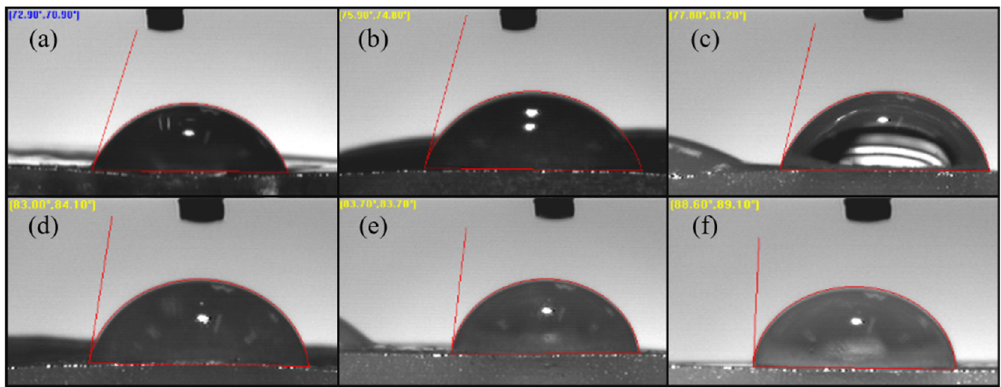
Figure 9. The contact angles of different concentrations of ( a ) AG10:50, ( b ) AGLC01, ( c ) AGLC05, ( d ) AGLC10, ( e ) AGLC20, and ( f ) AGLC40.